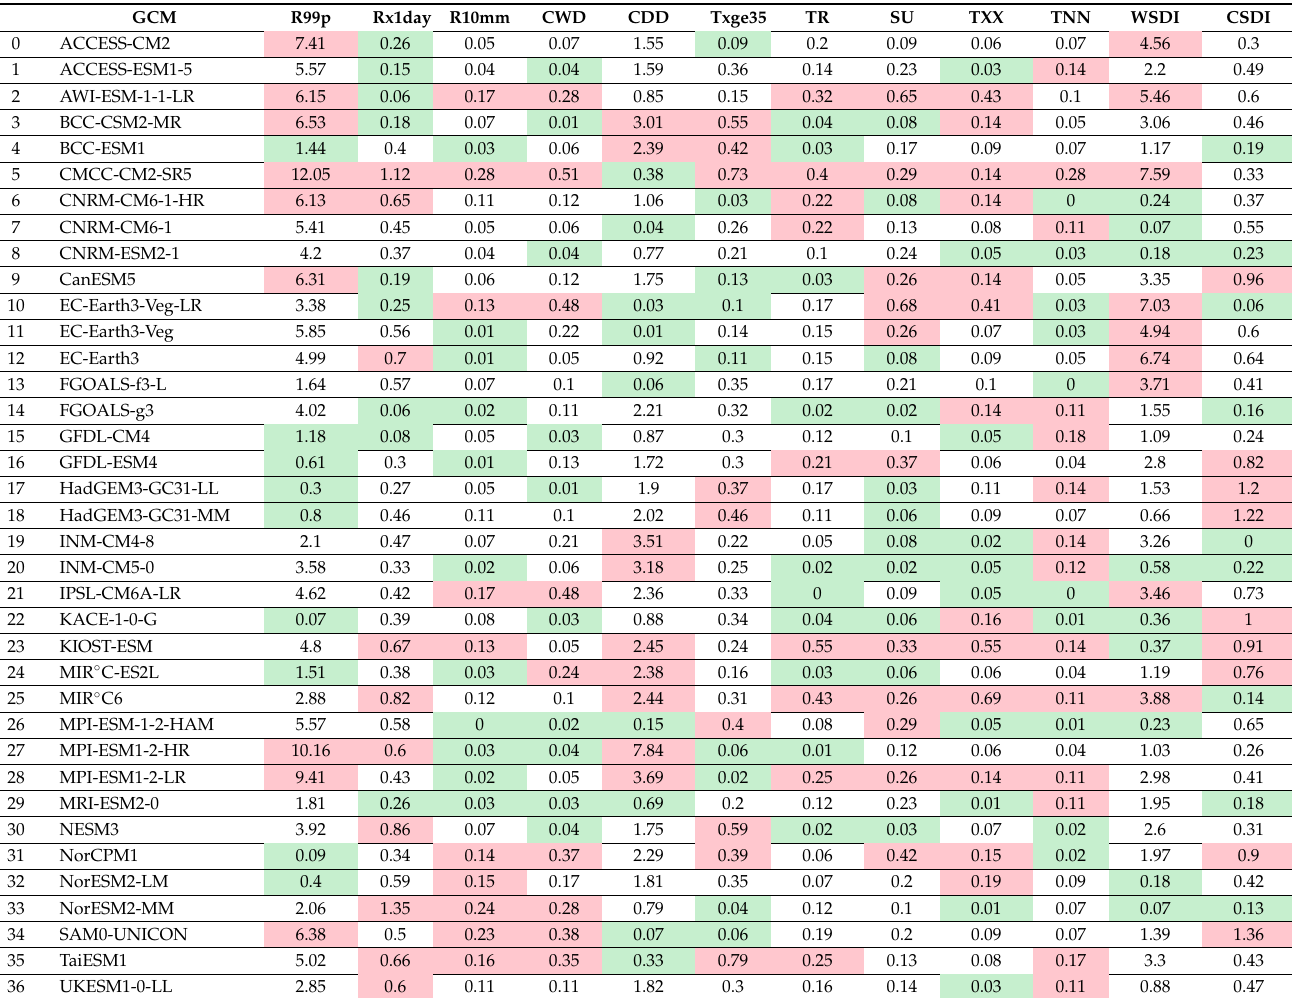
Table 6. Table of interannual variability score (IVS) recorded in 37 CMIP6 GCMs for the 12 extreme indices. A smaller value of IVS corresponds to the better performance of GCMs. Here, the colour green and red denote the best (top 25% subset) and worst (bottom 25% subset) performing